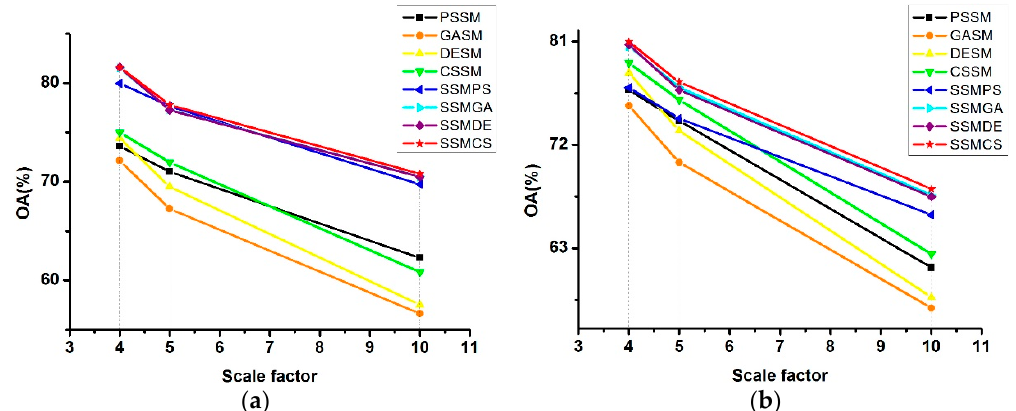
Figure 15. Sensitivity analysis of SSMCS and SSMDE in relation to scale factor s : ( a ) Sub-Pixel mapping in relation to scale factor s for the Landsat 8 image in Experiment 1; and ( b ) Sub-Pixel mapping in relation to scale factor s for the QuickBird image in Experiment 2.